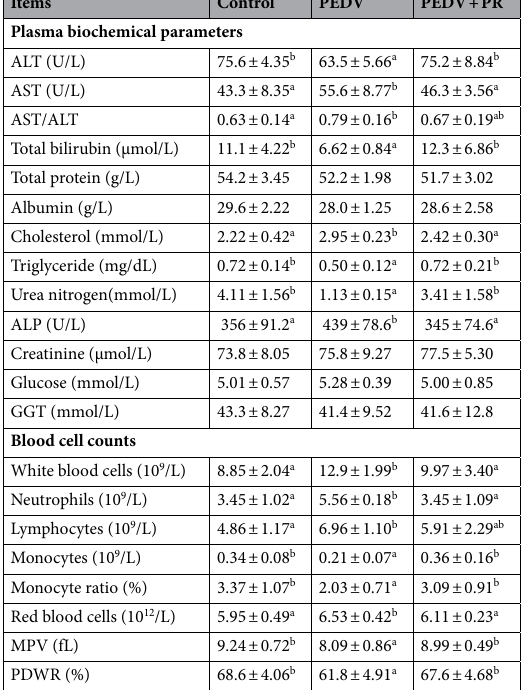
Table 1. Effects of puerarin (PR) administration on plasma biochemical parameters and immune cell numbers in piglets infected with PEDV. Values are mean and SD, n = 8. a,b Within a row, means with different superscripts differ (< 0.05). ALT, alanine aminotransferase; AST, aspartate aminotransferase; ALP, alkaline phosphatase; GGT, γ-glutamyltransferase; MPV, mean platelet volume; PDWR, Platelet distribution width ratio.